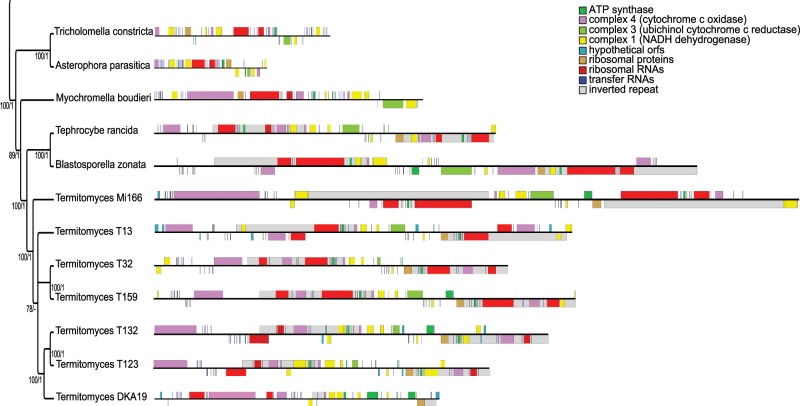
—Mitochondrial genomes of 12 Lyophyllaceae species. The phylogeny is rooted with Tricholoma matsutake, but the genome of this species is not included in the figure. Images of genomes created with OGDRAW (Lohse et al. 2013).